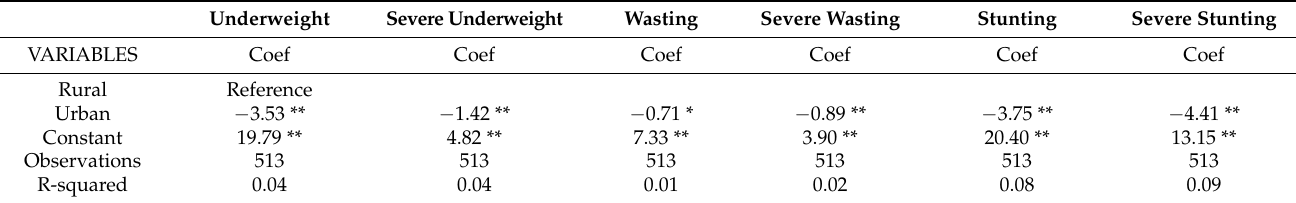
Table A1. Regression outputs for urban/rural